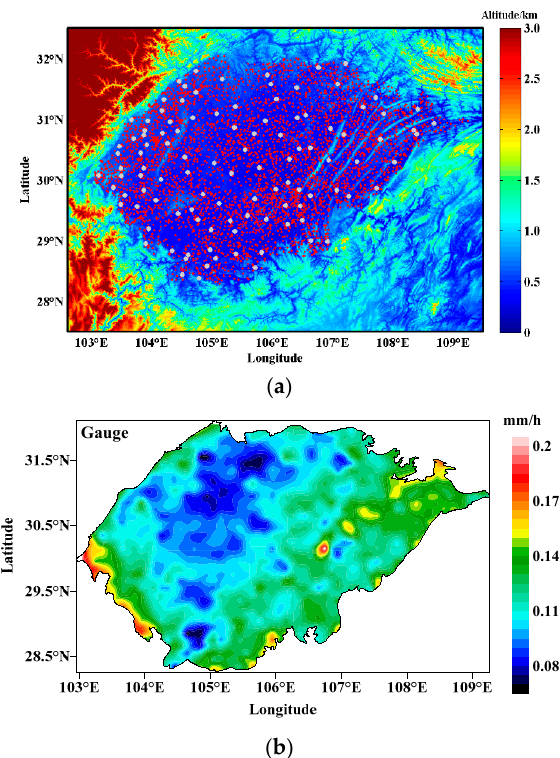
Figure 1. ( a ) Digital Elevation Model (DEM) of Sichuan Basin and locations of gauge stations (red points represent regional gauge stations and large gray dots represent national gauges stations); ( b ) spatial distributions of mean hourly precipitation observed by gauge over Sichuan Basin during 2016–2018.